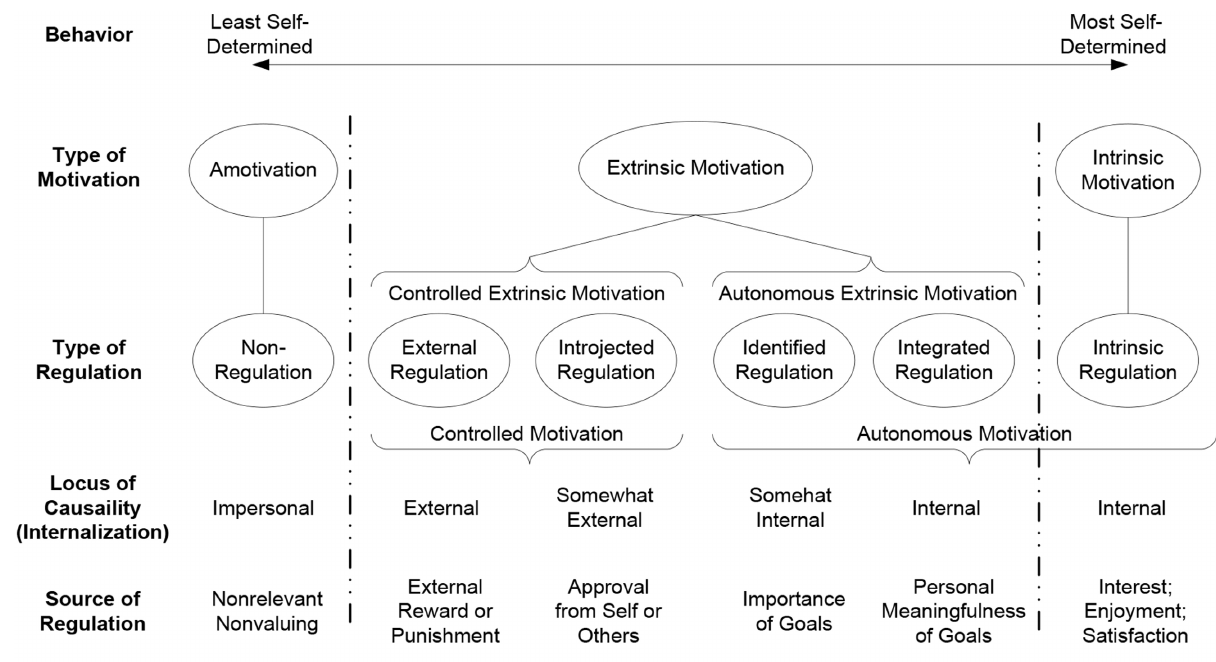
FIGURE 2 | Self-determination